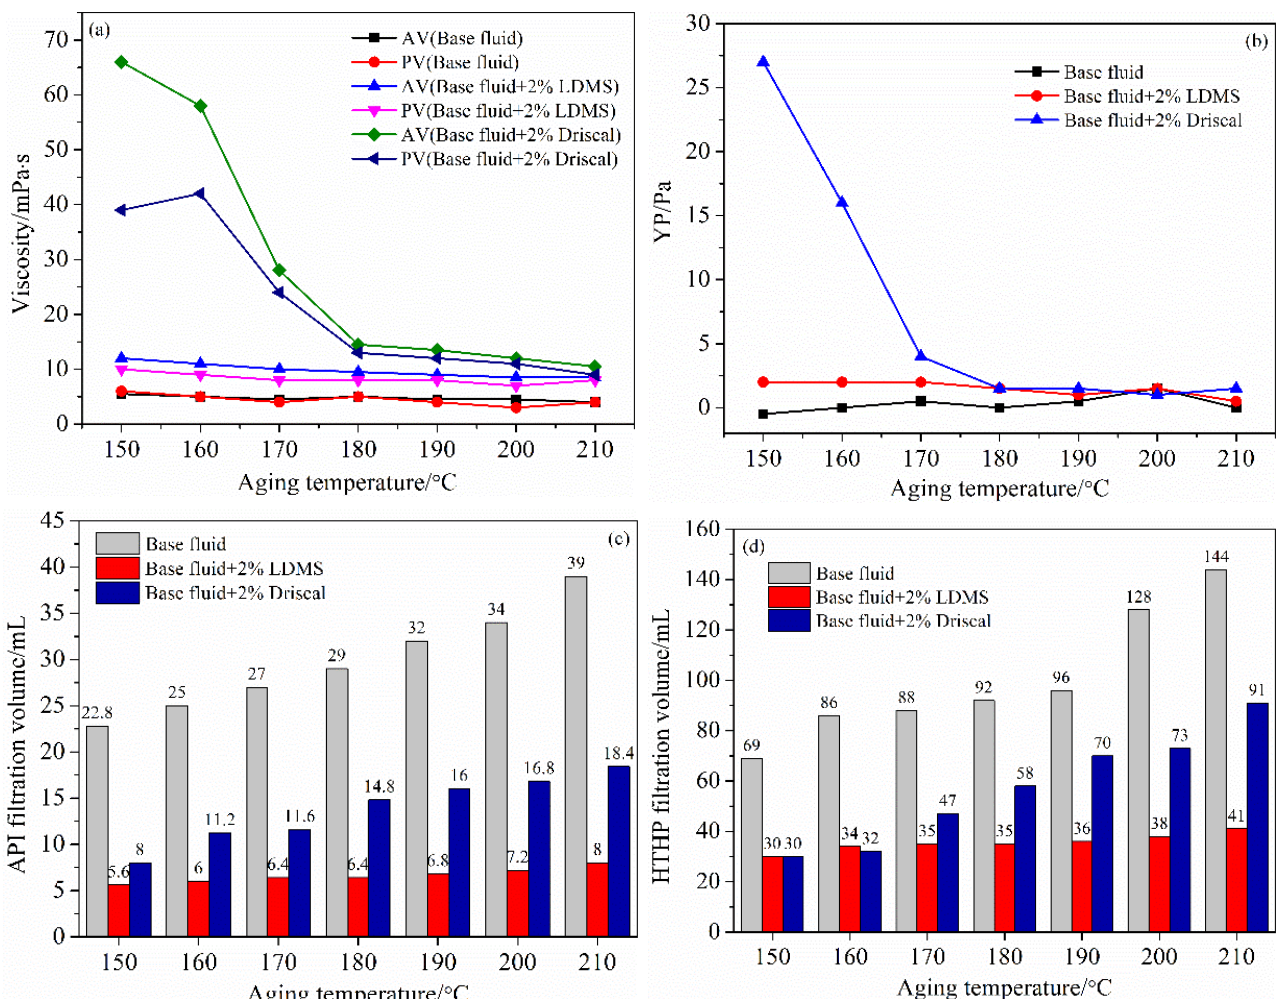
Figure 6. Effect of temperature on the viscosity ( a ), YP ( b ), API filtration ( c ), and HTHP filtration ( d ) of drilling fluids.